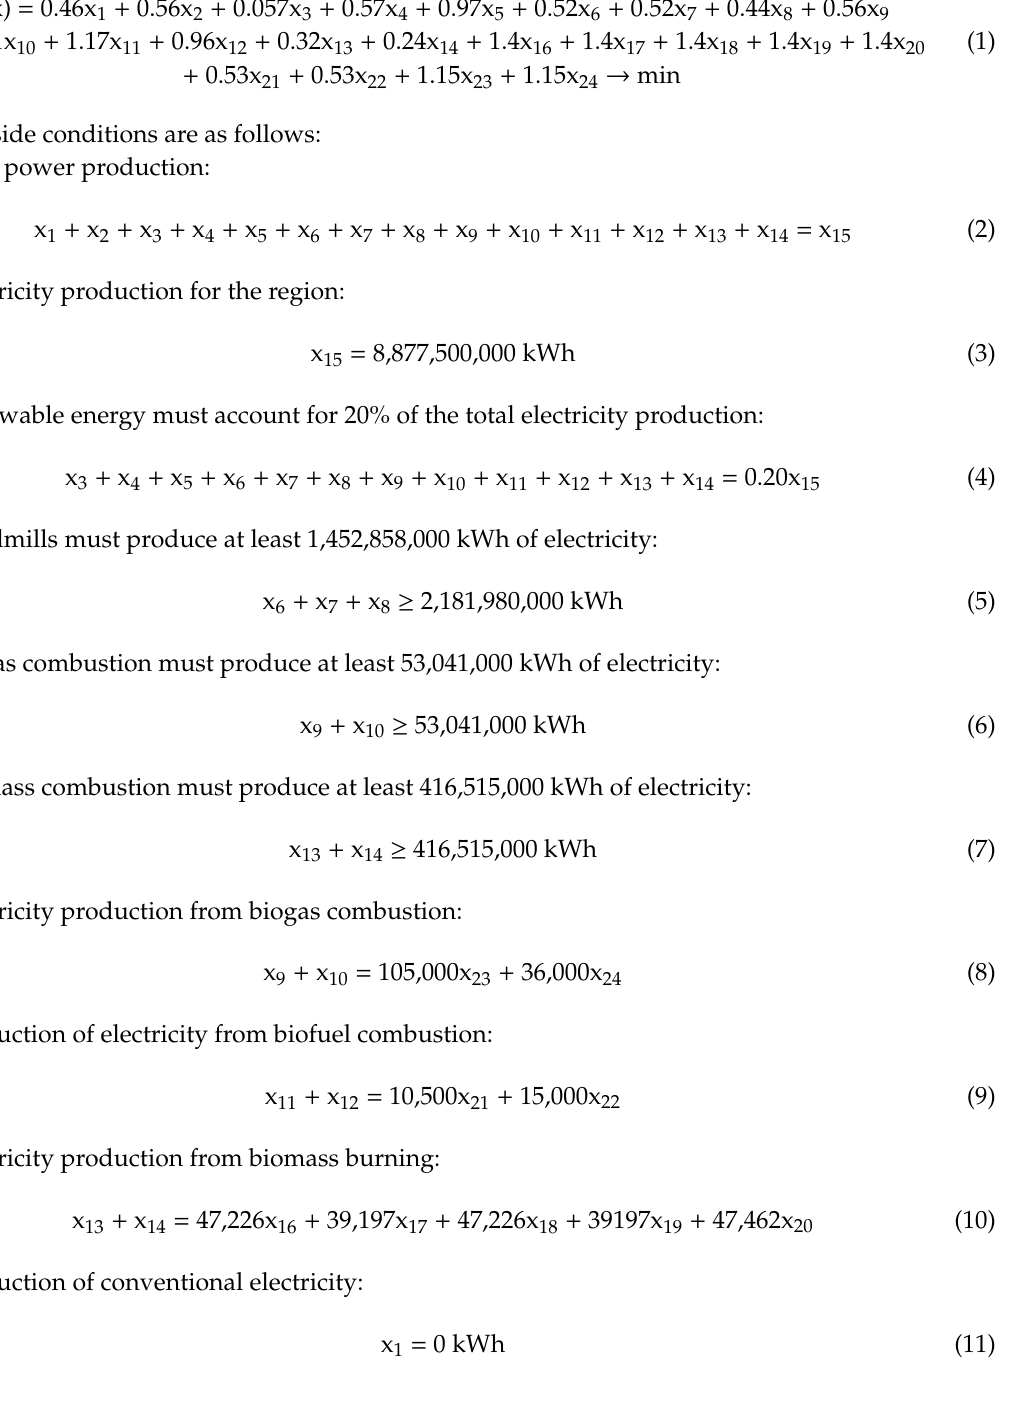
Table 10. Cost of power production from energy plants (in kWh / ha) according to scenario I. Energy Resources x 16 x 17 x 18 x 19 x 20 x 21 x 22 x 23 x 24 Manufacturing cost 0.18 0.35 0.17 0.07 0.04 0.5 0.5 0.21 Source: Own study based on the